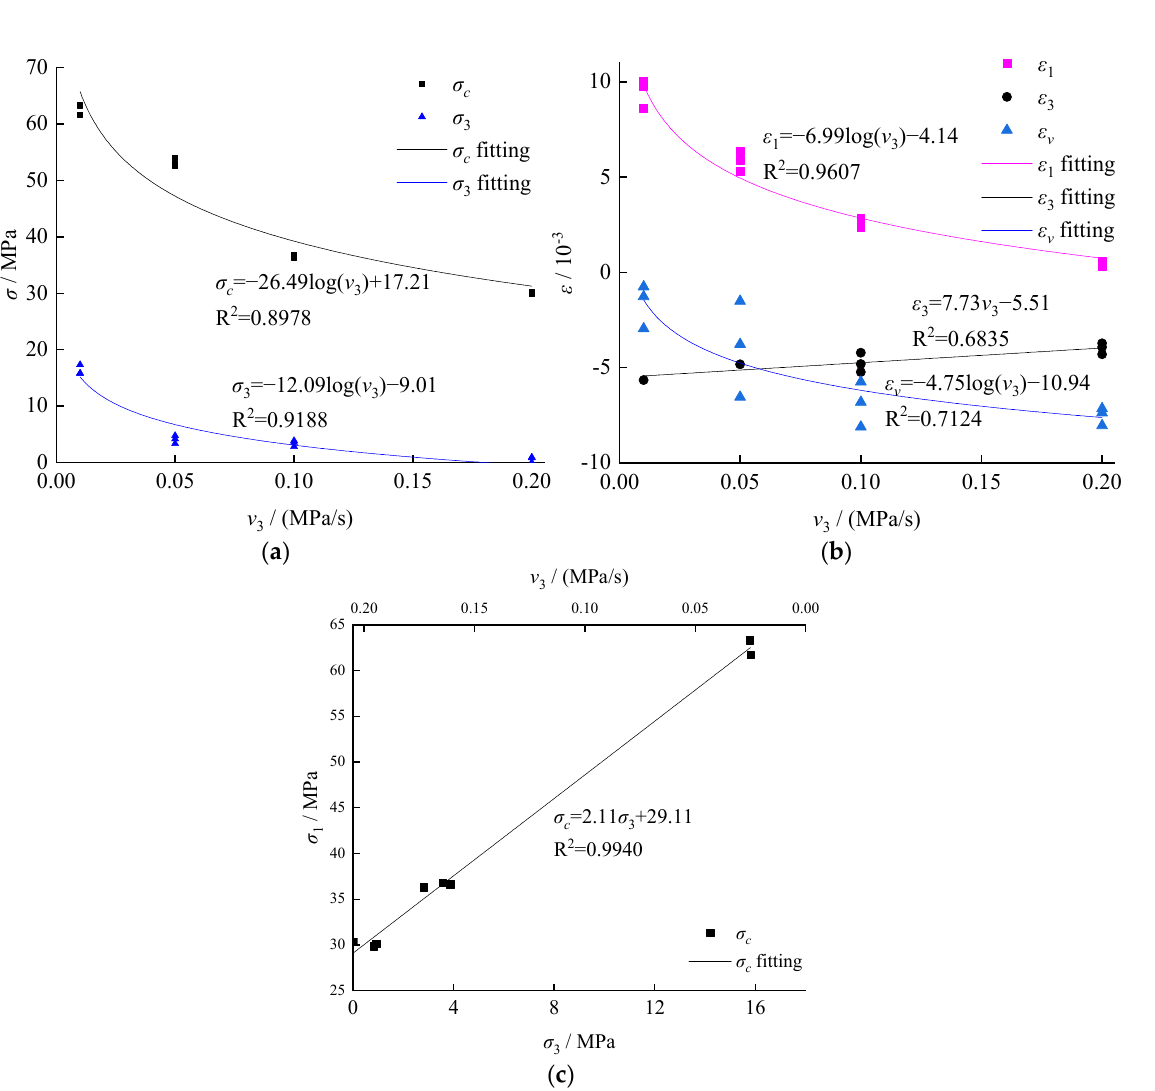
Figure 5. Relation among strain, stress, and unloading rate of the confining pressure: ( a ) failure strength and confining pressure, ( b ) strain, and ( c ) relation among the unloading rate of the confining pressure, the confining pressure, and failure strength.